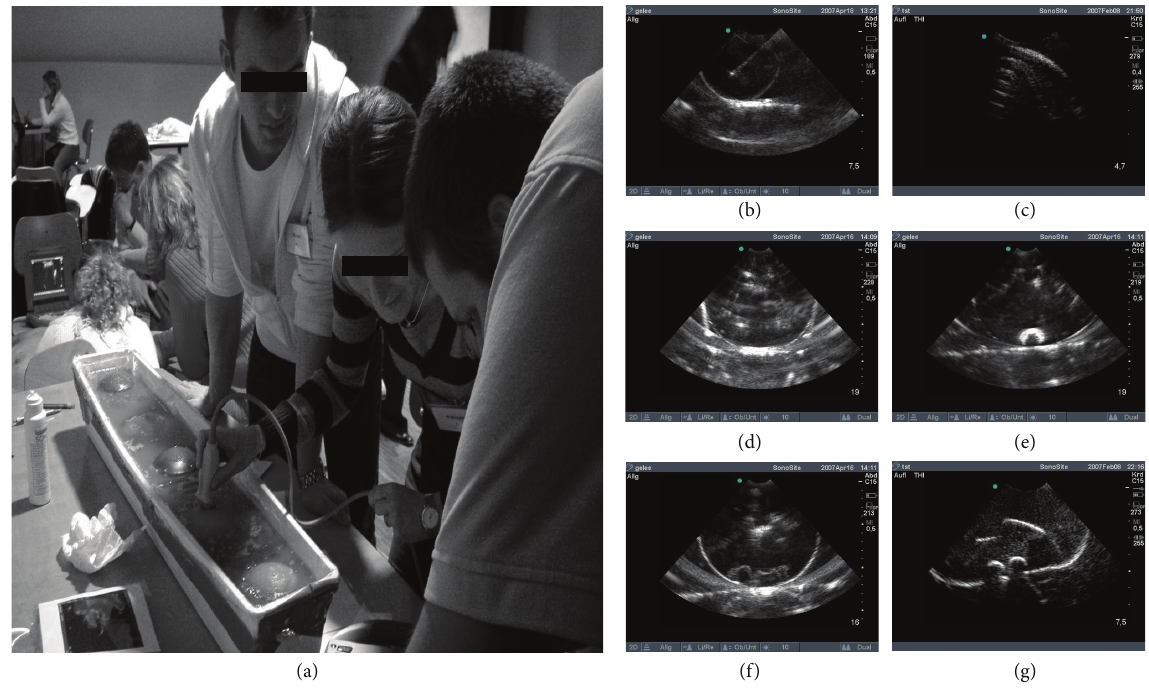
Figure 1: (a) Representative training station with ultrasound phantom. (b)–(g) B-mode sonograms of ultrasound dummies filled with various components to mimic characteristic findings and artifacts of ultrasound examination of the chest. (b) Liquid filled dummy simulates pleural line and PLE. Note the presence of a needle artifact (long axis); (c) dummy filled with air to mimic reverberation artifacts typically found in PTX, (d) dummy filled with rice grains and starch to mimic partly consolidated hemothorax or fibrinous structures, (e) olive as substitute for soft but solid tissue, (f) jelly babies, and (g) a wooden tiger duck for identification of target objects.